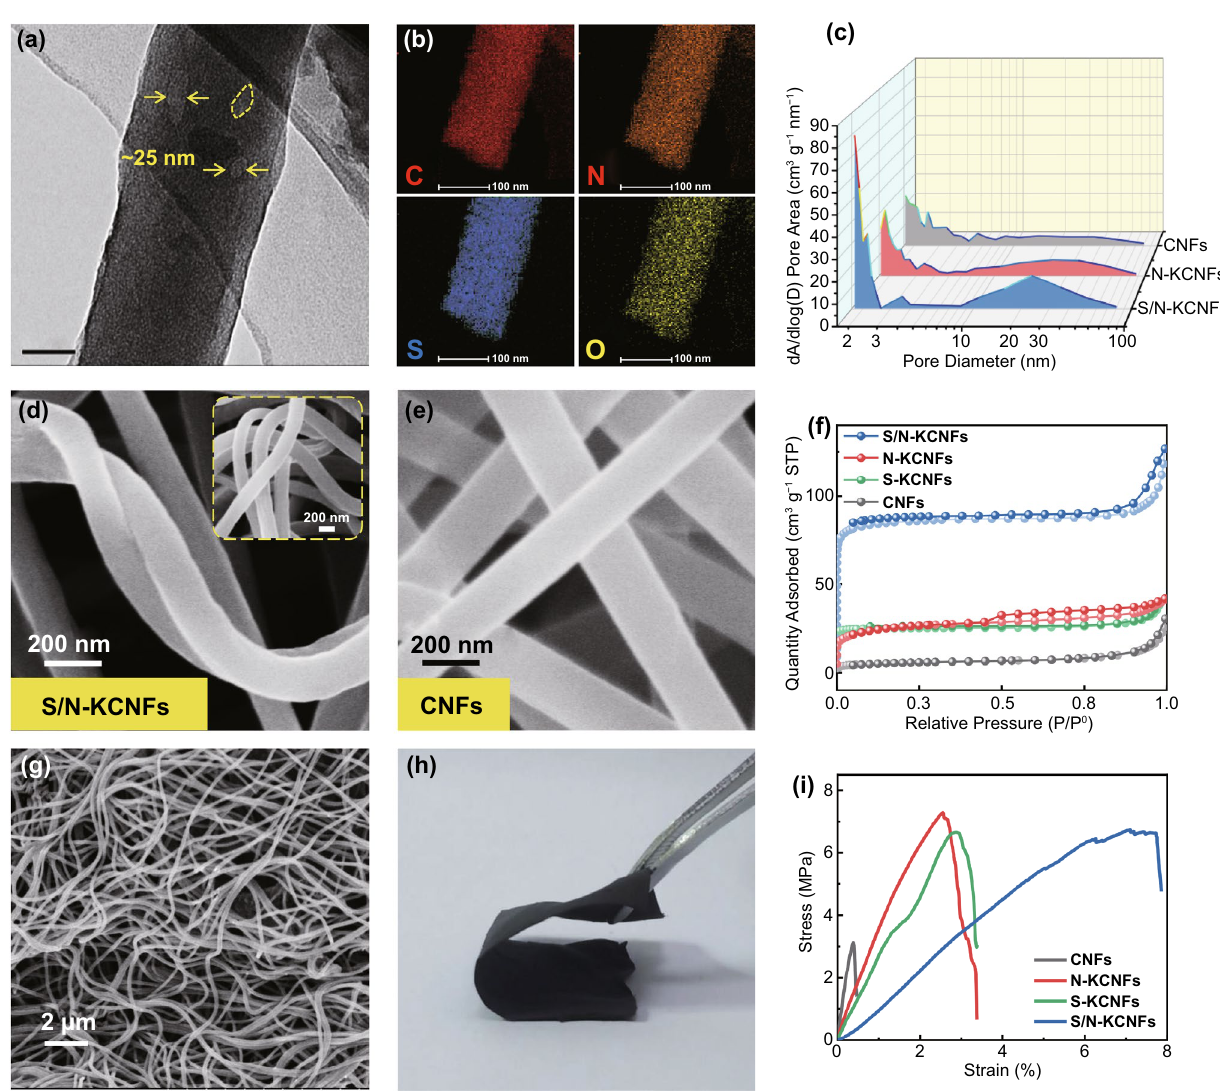
Fig. 4 a TEM image, b EDS element mapping (C, N, O, and S elements), and d, g SEM image corresponding to S/N-KCNFs; e SEM image of CNFs; c the pore size distribution and f nitrogen adsorption–desorption isotherms curve of S/N-KCNFs, N-KCNFs, S-KCNFs and CNFs; h digi- tal photographs of S/N-KCNFs bending; i The stress–strain curves of S/N-KCNFs, N-KCNFs, S-KCNFs, and CNF